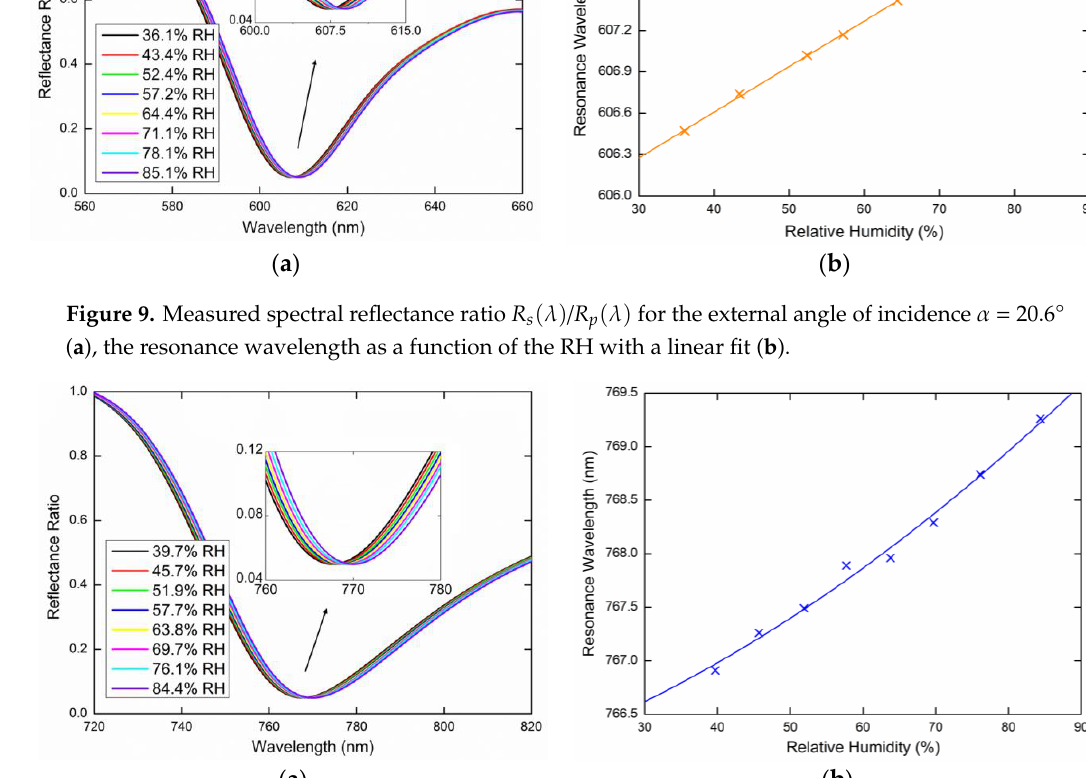
Figure 10. Measured spectral reflectance ratio 𝑅 45 (𝜆) / 𝑅 𝑠 (𝜆) for the external angle of incidence 𝛼 = 16.6° ( a ), the resonance wavelength as a function of the RH with a second-order polynomial fit ( b ).